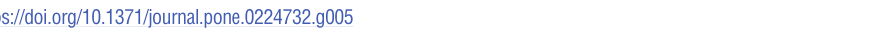
PLOS ONE | https://doi.org/10.1371/journal.pone.0224732 November12,